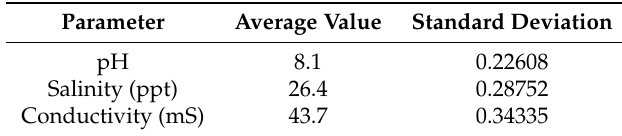
Table 3. Parameters of the seawater.